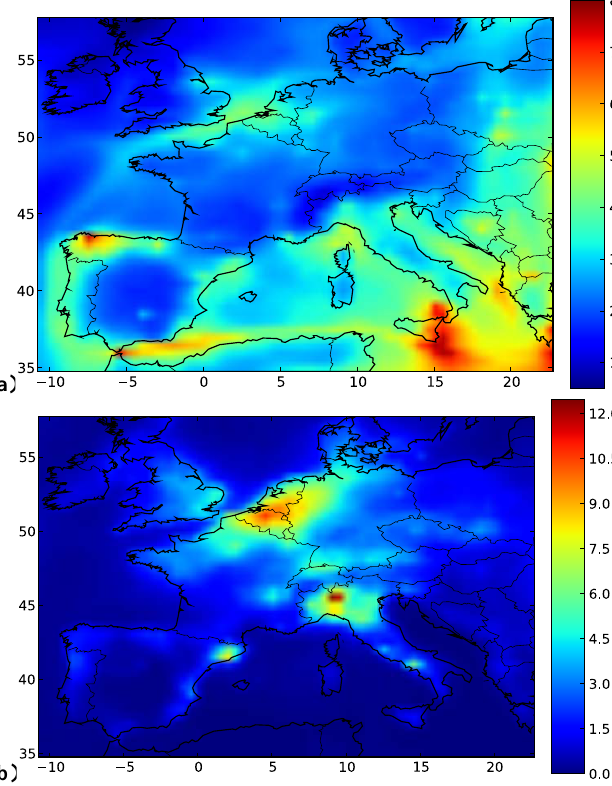
Fig. 8. Differences (CB05 – RACM2, µgm − 3 ) of SOA formed from (a) BiISO1 and (b) BiISO2 over